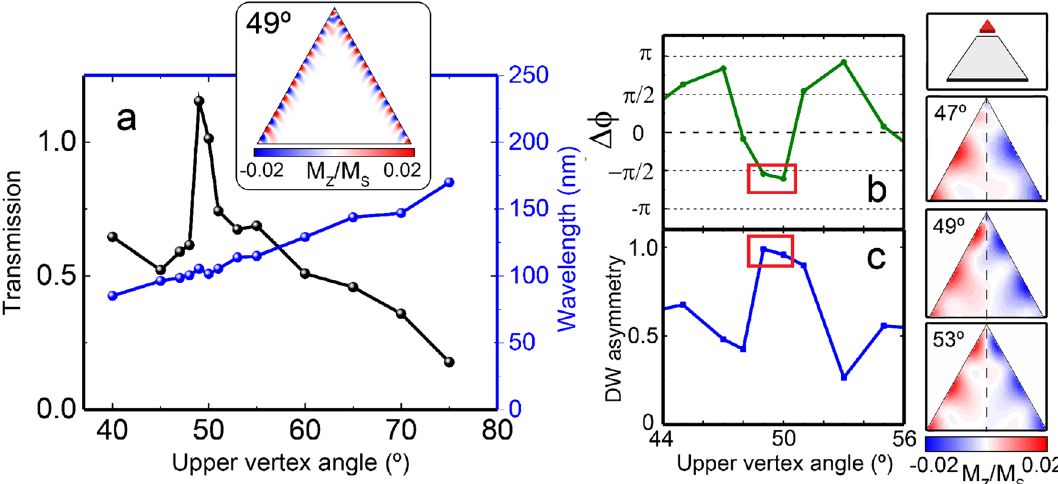
a 𝜋 /2 phase shift, indicating the possible existence of resonance. c Normalized DW asymmetry between the two lateral sides of the triangle in the propagation of the ESW indicates a more asymmetri- cal propagation for the high transmission angles. Insets reveal an enhancement of the upper vertex DW, showing a snapshot of the SWs once the propagation is steady for three different angle aper- tures. Enhanced area is marked in red in the top inset, which consti- tutes approximately only 17.5 % of the in-plane length of the whole